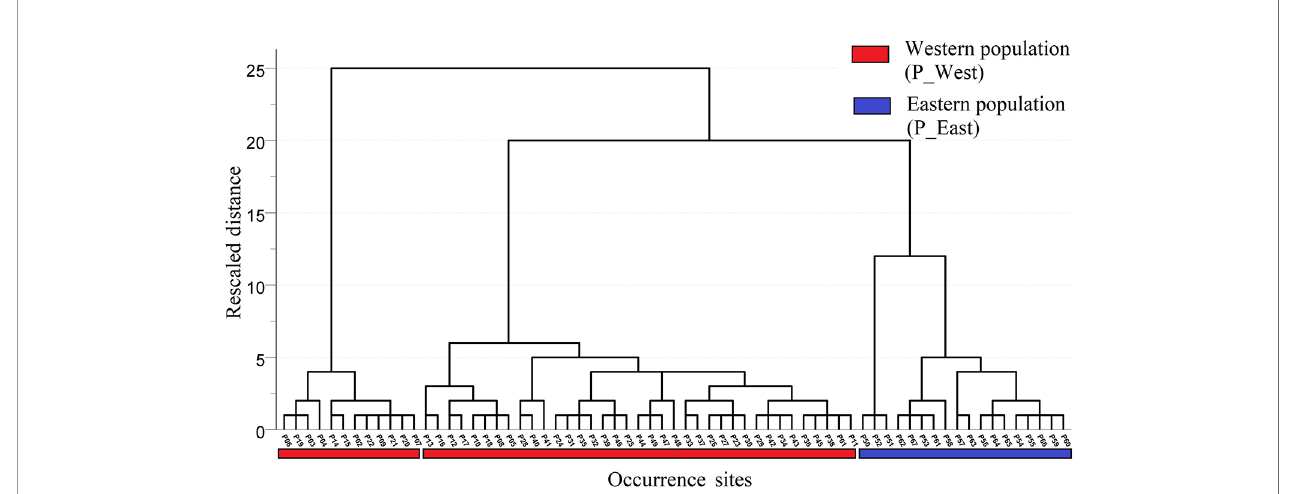
FIGURE 3 | Result of hierarchical cluster analysis. All sites of occurrence could be grouped into three groups: two groups for P_West and one group for P_East.